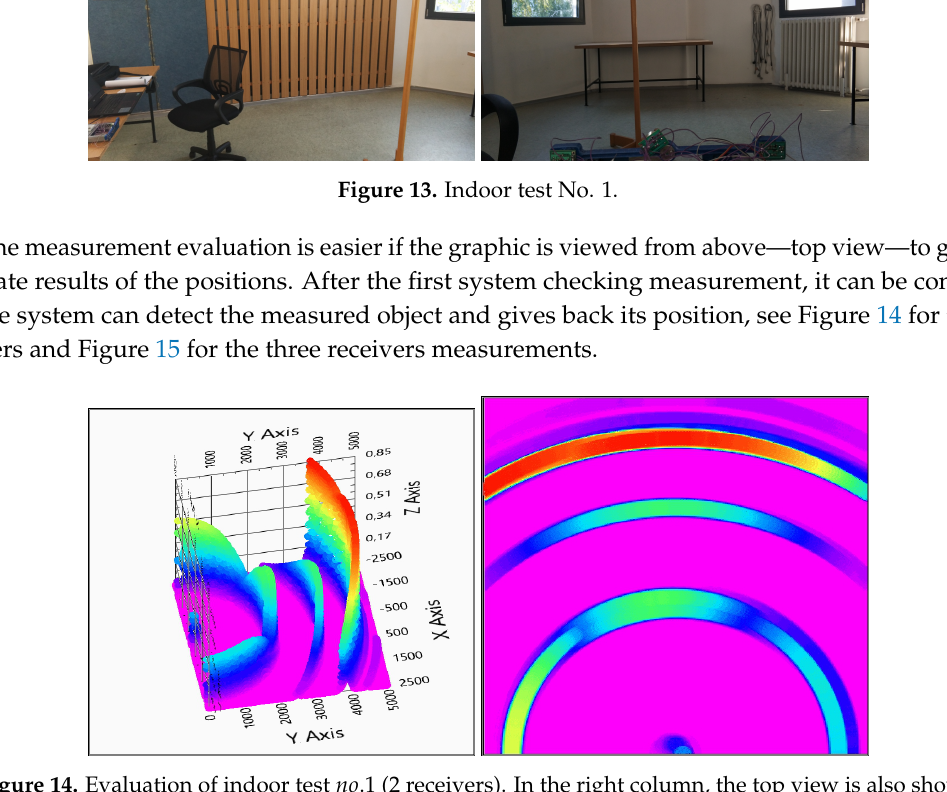
Figure 14. Evaluation of indoor test no .1 (2 receivers). In the right column, the top view is also shown ( x , y : x , y space axis, z -axis: probability of solid object in x , y defined position).